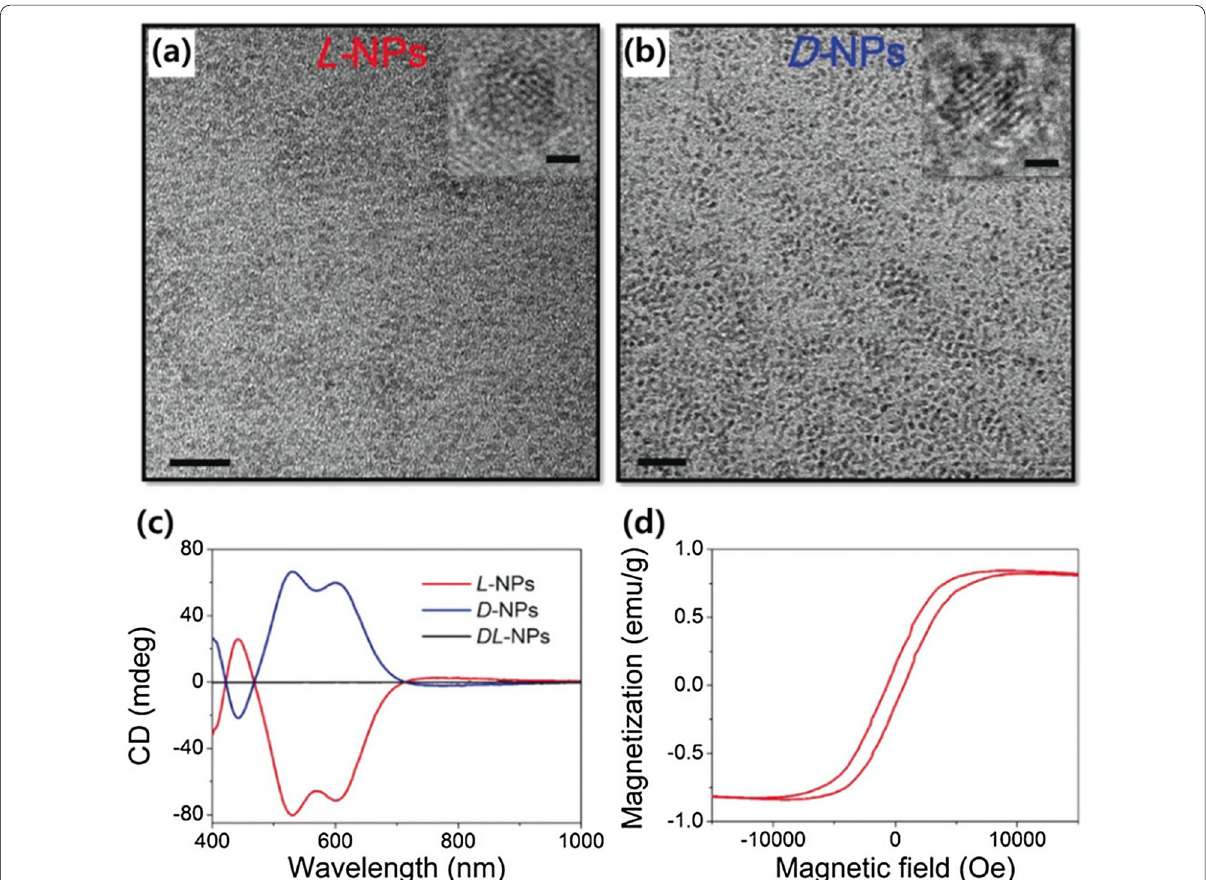
Fig. 9 Transmission electron microscope (TEM) images of a l - and b d -penicillamine stabilized Cu x Co y S NPs, scale bar insets are TEM images of single NPs, scale